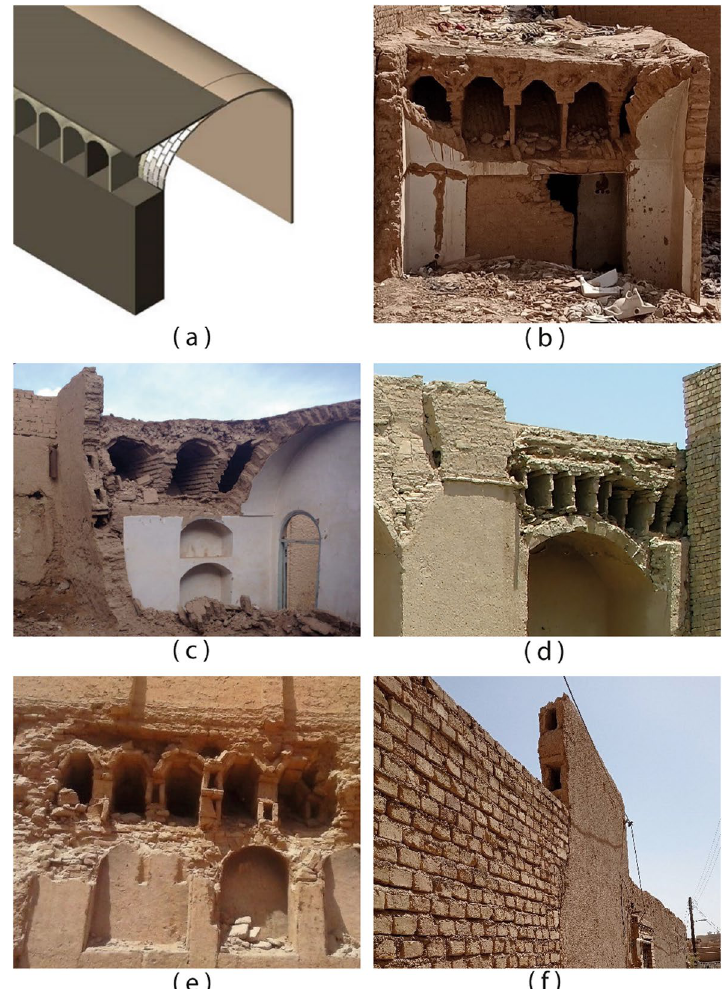
Fig. 8 Techniques used to lightening the building weight and lowering its centre of gravity: ( a ) a schematic view of Konou (Source: Fakhar Tehrani 1998), ( b ) Konou in the vault transversal direction, ( c ) thick Konou in the vault transversal direction, ( d ) Konou in the vault longitudinal direction, ( e ) combination of Konou and Sandoghe‑chini, and ( f ) Sandoghe‑chini upon the fence walls (Source of b‑f: the